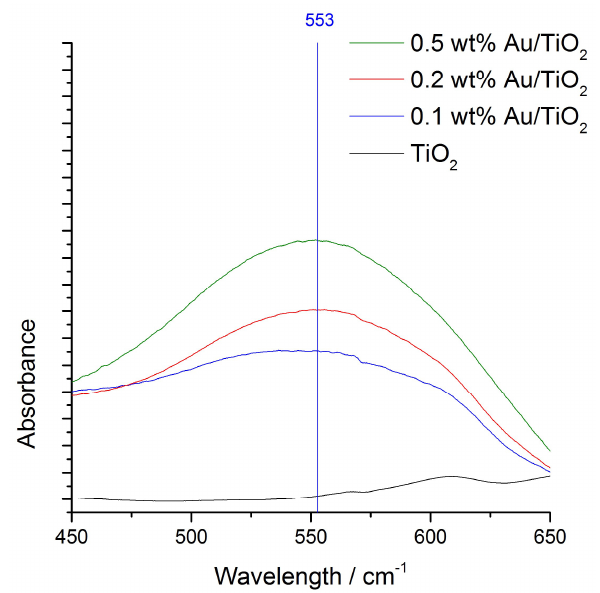
Figure 1. Enlarged UV-vis region of spectra for surface plasmon resonance band of Au/TiO 2 photocatalysts changing the gold loading.